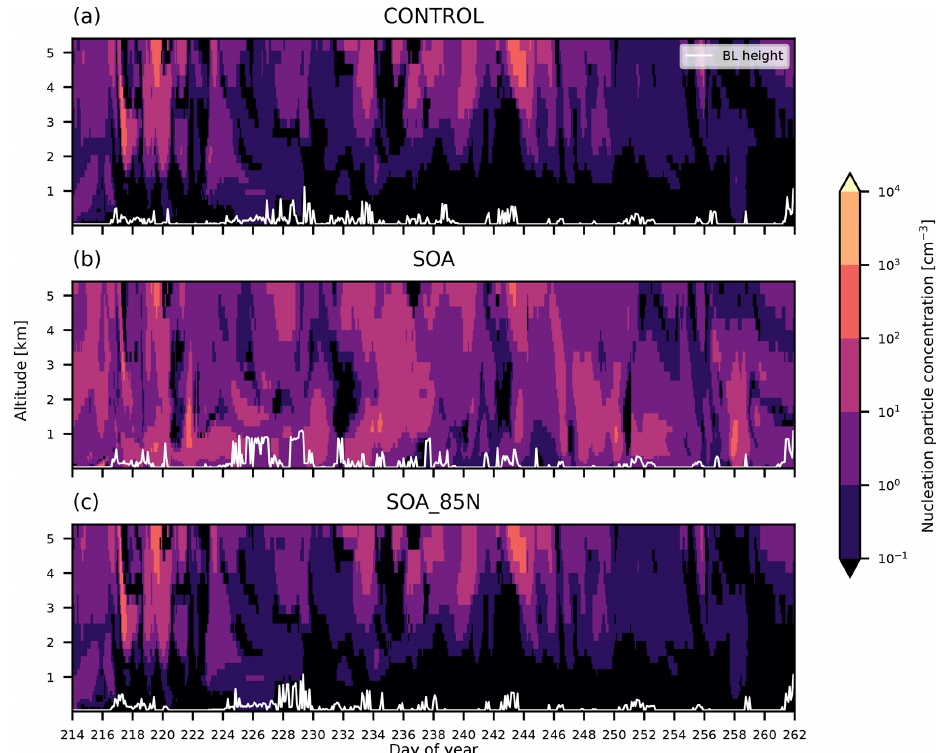
Figure 4. Nucleation mode aerosol profiles simulated for the AO2018 campaign period. Model output is from simulations (a) CONTROL, (b) SOA, and (c) SOA_85N. Model output was collocated with the position of the Oden . White lines show BL